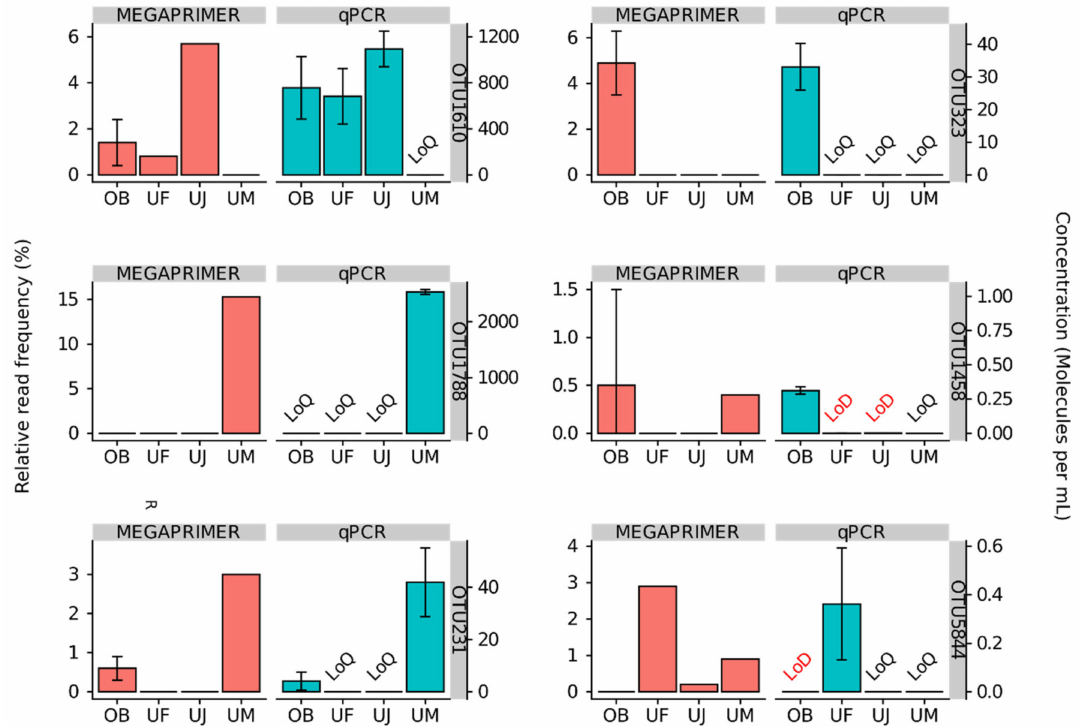
Figure 5. Relative read frequencies and qPCR quantification of selected six OTUs in four samples. The relative read frequency in the Osaka Bay sample was calculated by averaging all Osaka Bay sequencing results of this study. For Uranouchi Inlet samples, the relative read frequency in the S-UF-MP10 (UF), S-UJ-MP10 (UJ) and S-UM-MP10 (UM) datasets are shown. The error bar